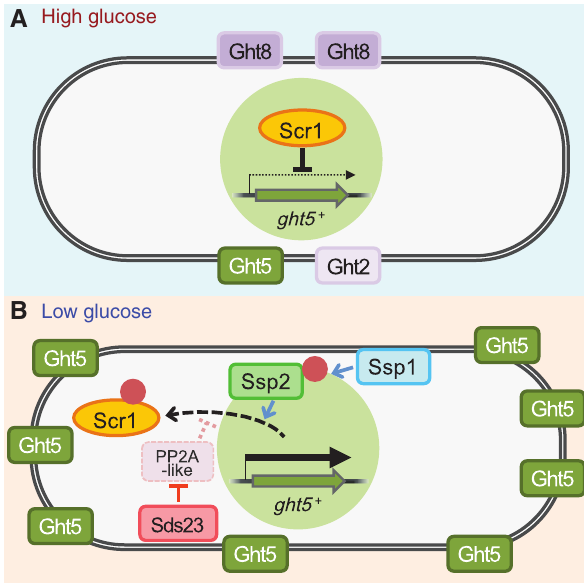
Figure 1: Model of the mechanism underlying regulation of glucose transporter